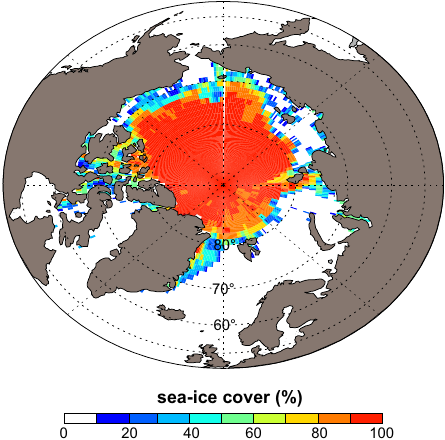
Figure 1. August sea-ice fraction used to scale sea-air fluxes in Fig. 1. August sea-ice fraction used to scale sea-air fluxes in GLOMAP. coupling, Oceanography, 24, 220–231, 2011.